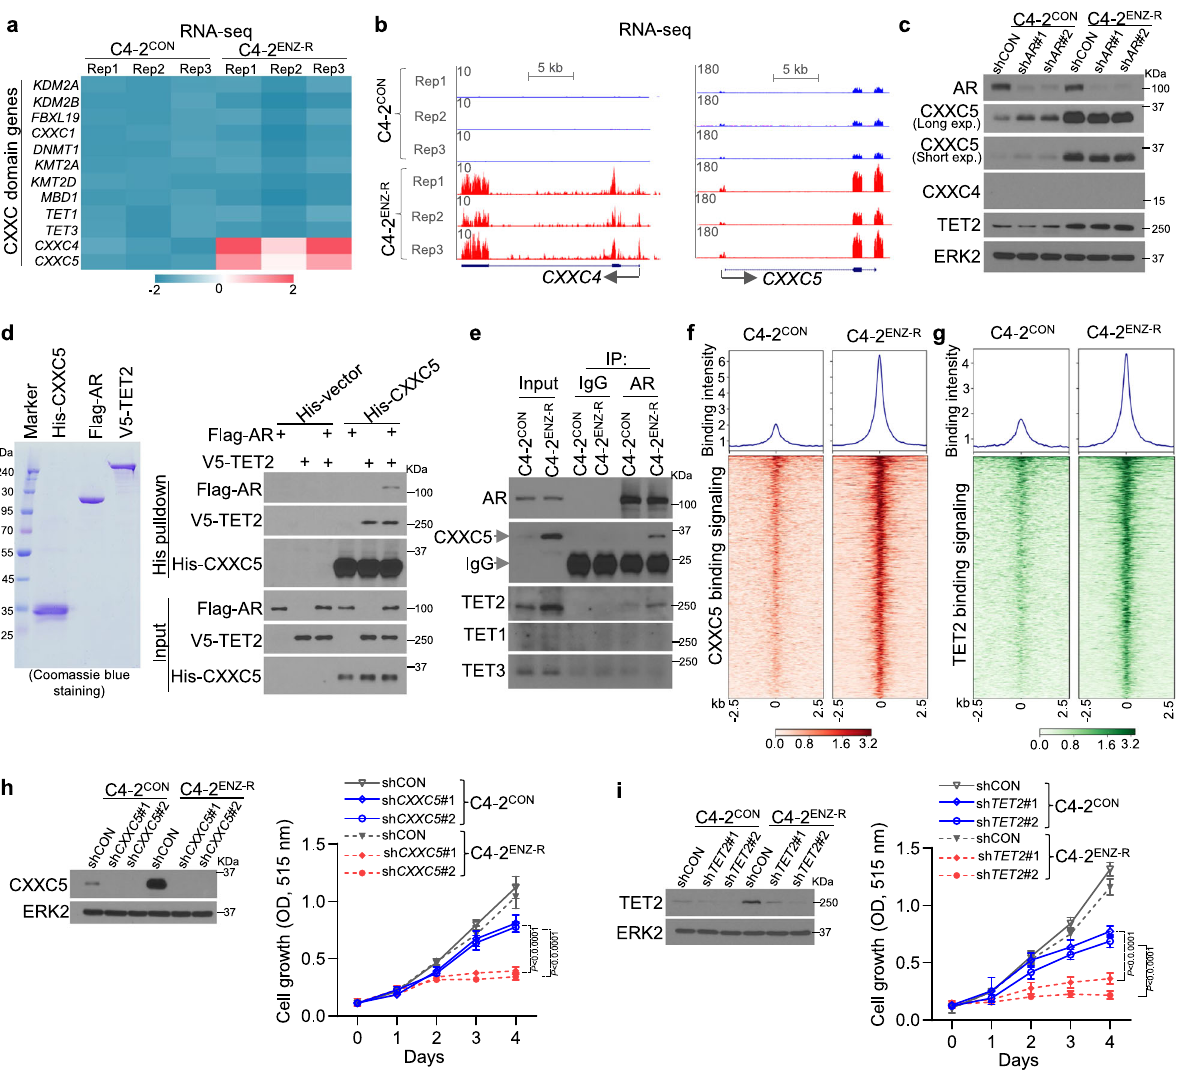
Fig. 2 CXXC5 and TET2 occupancy at ARBS-gained CpGi-positive sites in ENZ-resistant CRPC cells. a Heatmap showing RNA-seq read intensity of 12 CXXC domain genes in C4-2 CON and C4-2 ENZ-R cells. b UCSC tracks showing RNA-seq signal pro fi les of CXXC4 and CXXC5 expression in C4-2 CON and C4-2 ENZ-R cells. c Western blotting showing the AR, CXXC5, CXXC4, and TET2 protein level in cells expressing control or AR-speci fi c shRNAs. ERK2 was used as a loading control. d In vitro pulldown analysis of CXXC5 interaction with AR and TET2 using proteins puri fi ed from baculovirus-insect Sf9 cell expression system. e Co-IP of endogenous proteins shows AR interaction with CXXC5, TET1, TET2, and TET3 in C4-2 CON and C4-2 ENZ-R cells. f , g Heatmap (integration of all replicates) shows ChIP-seq read intensity of CXXC5 and TET2 at ARBS-gained regions in C4-2 CON and C4-2 ENZ-R cells. h , i CXXC5 or TET2 was knocked down by speci fi c shRNAs in C4-2 CON and C4-2 ENZ-R cells and the cell proliferation was measured by SRB assay. Data are represented as means± s.d. ( n = 6 replicates/group). Statistical signi fi cance was determined by two-way ANOVA. Experiments in c – e were repeated